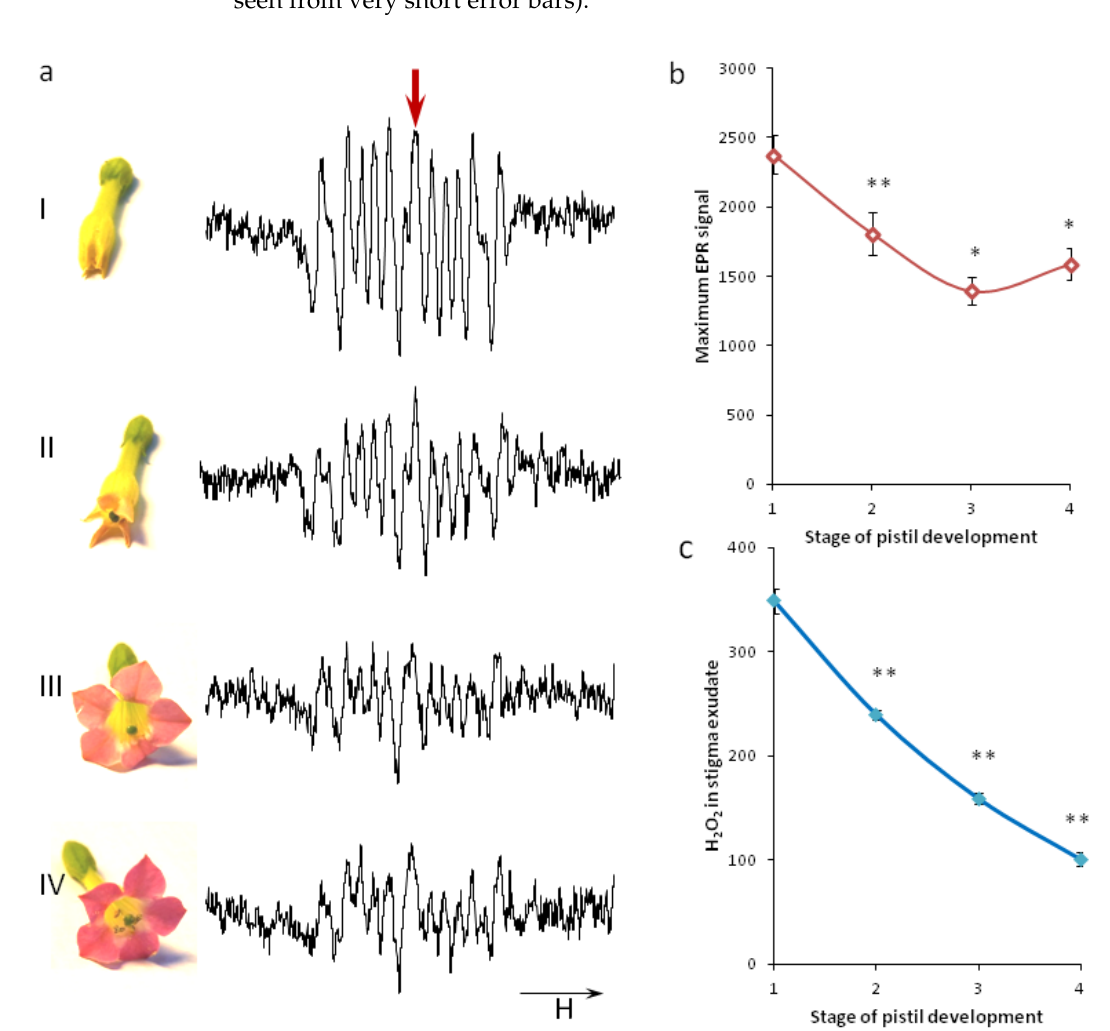
Figure 1. ROS dynamics on tobacco stigma: ( a ) stages of flower development and corresponding typical EPR signals of stigma exudate; ( I – III ) unpollinated flowers; ( IV ) pollinated flower (24 h after pollination); ( b ) averaged values of EPR signals (the second peak, indicated by an arrow in ( a )), n = 6 ( I ), 7 ( III ), 9 ( II , IV ); ( c ) H 2 O 2 in stigma exudate assessed by FOX-1 method, n = 5 ( I ), 8 ( II , III ), 7 ( IV ). The direction of the magnetic field sweep is shown by an arrow below the spectra. Each exudate aliquot (n) was collected from 25–40 (EPR), 15–25 (spectrophotometry) flowers of the same stage. Asterisks indicate a significant difference between the means (* - p <0,05, **- p <0,01).